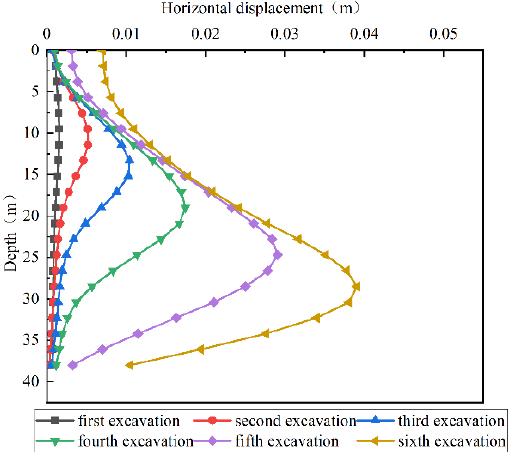
Figure 20. Horizontal displacement curve of foundation pit excavation enclosure structure with a seepage point at 0.005 m.